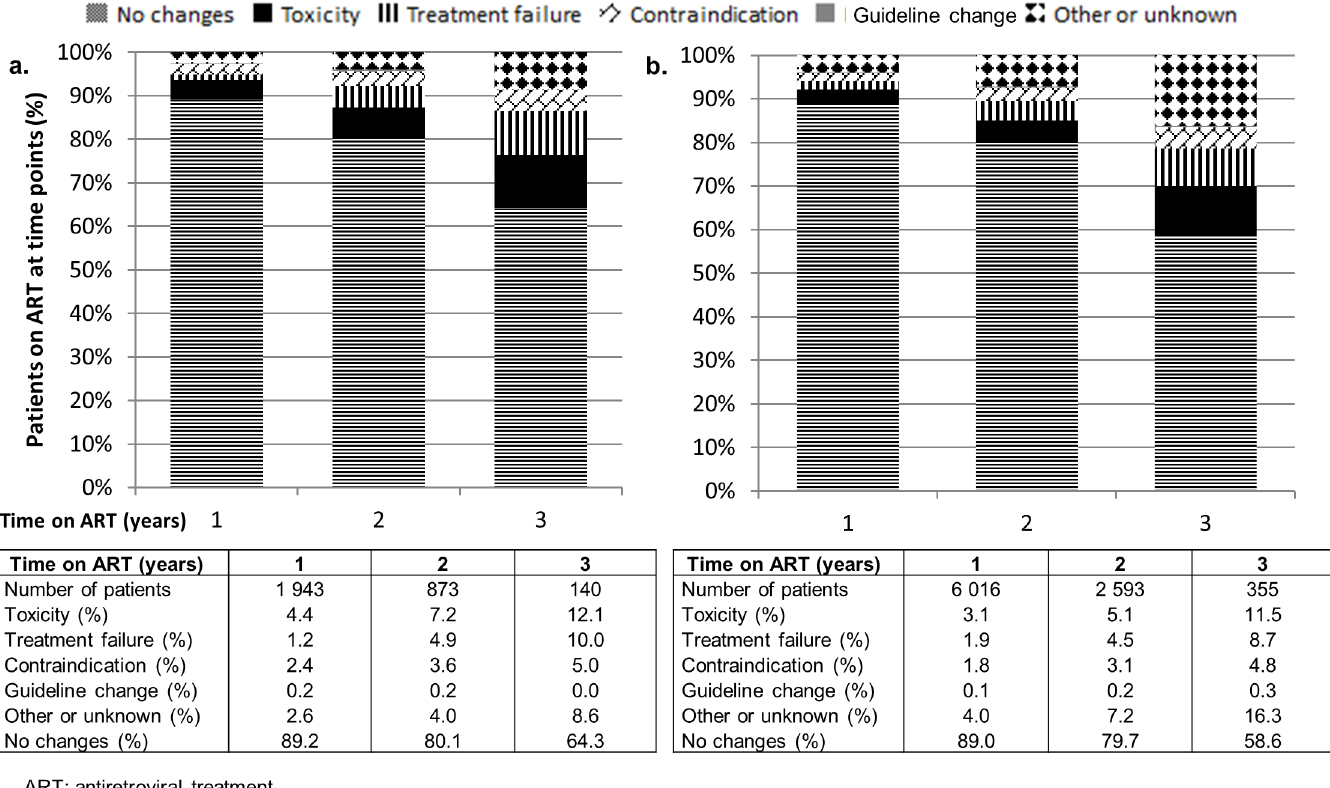
Fig 1. Antiretroviral discontinuations amongst a. enhanced-data sample patients (n = 3 837) and b. routine-data patients (n = 11 559) from two South African cohorts, who initiated antiretroviral treatment from 2010–2013 (denominator is those who remained alive and in care for 1, 2, and 3 years after ART initiation respectively).